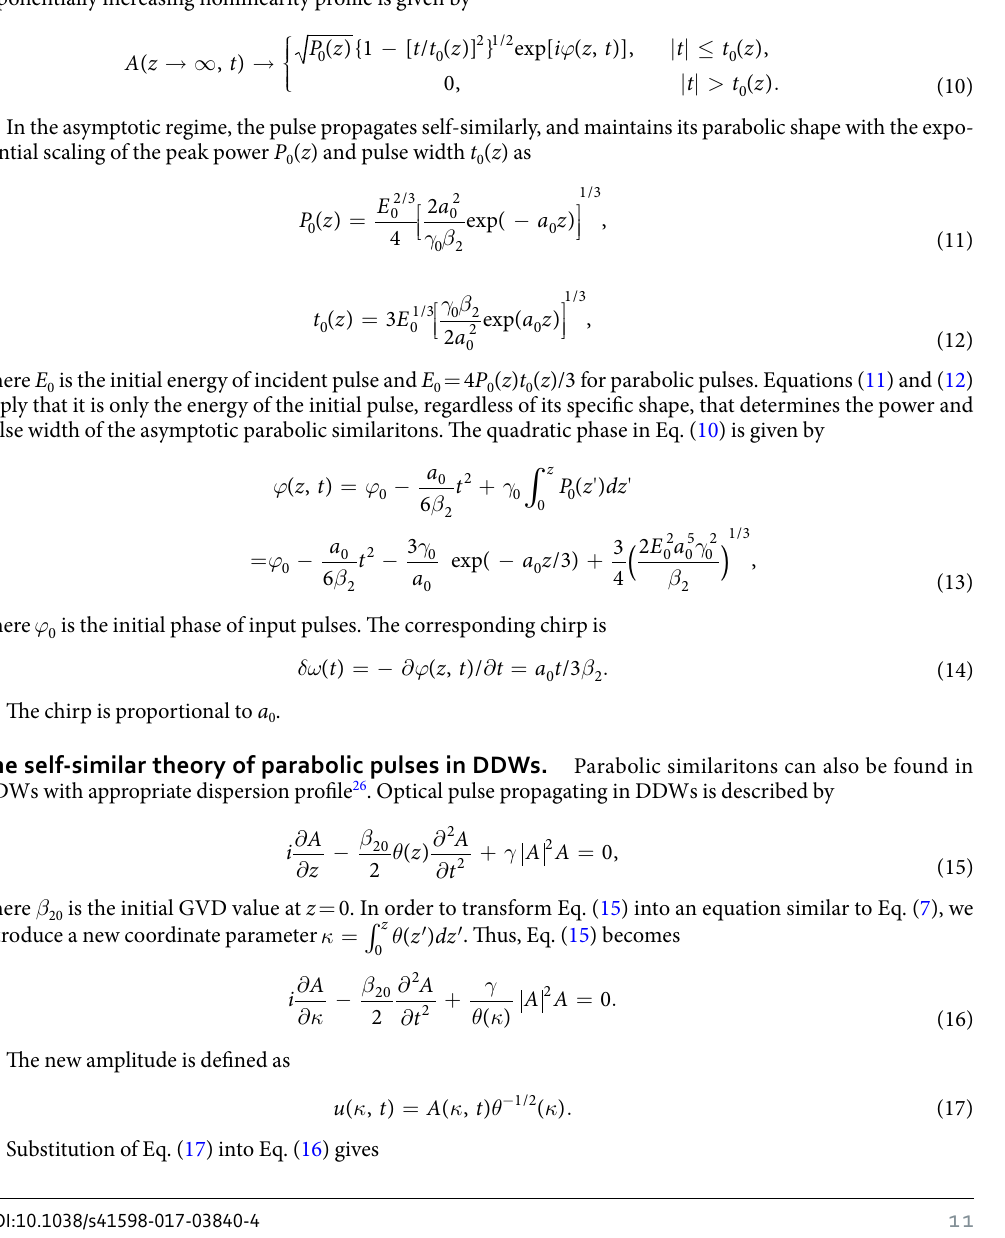
the equivalent gain coefficient becomes a constant. The NLSE of Eq. (8) with normal dispersion and constant gain can be solved analytically by using symmetry reduction. The solutions obtained in this way represent exact self-similar solutions which appear in the asymptotic limit z → ∞ 49, 50 . The asymptotic solution in NIW with an exponentially increasing nonlinearity profile is given by 12